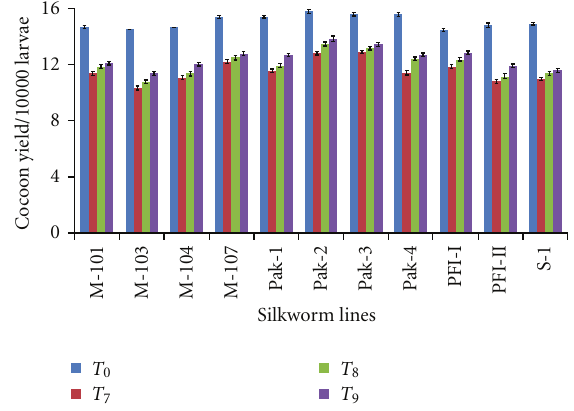
Figure 12: Comparative performance of cocoon yield (mean ± SE) of eleven silkworm lines at 35 ± 1 ◦ C in combination with 55, 65, and 75% RH and controlled conditions of temperature and RH (25 ± 1 ◦ C and 70–80%,